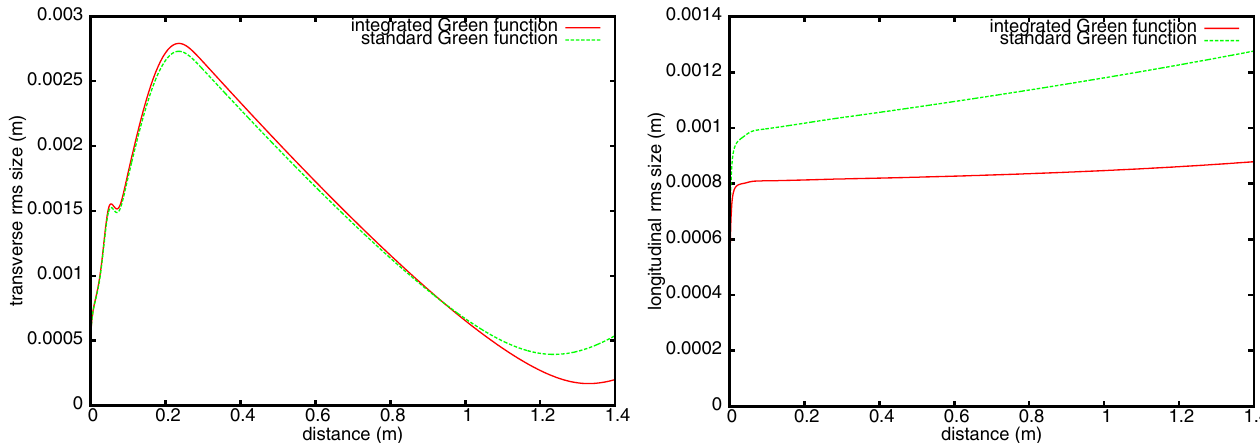
FIG. 7. (Color) Transverse (left) and longitudinal (right) rms sizes as a function of distance from the simulation using the standard and integrated Green function